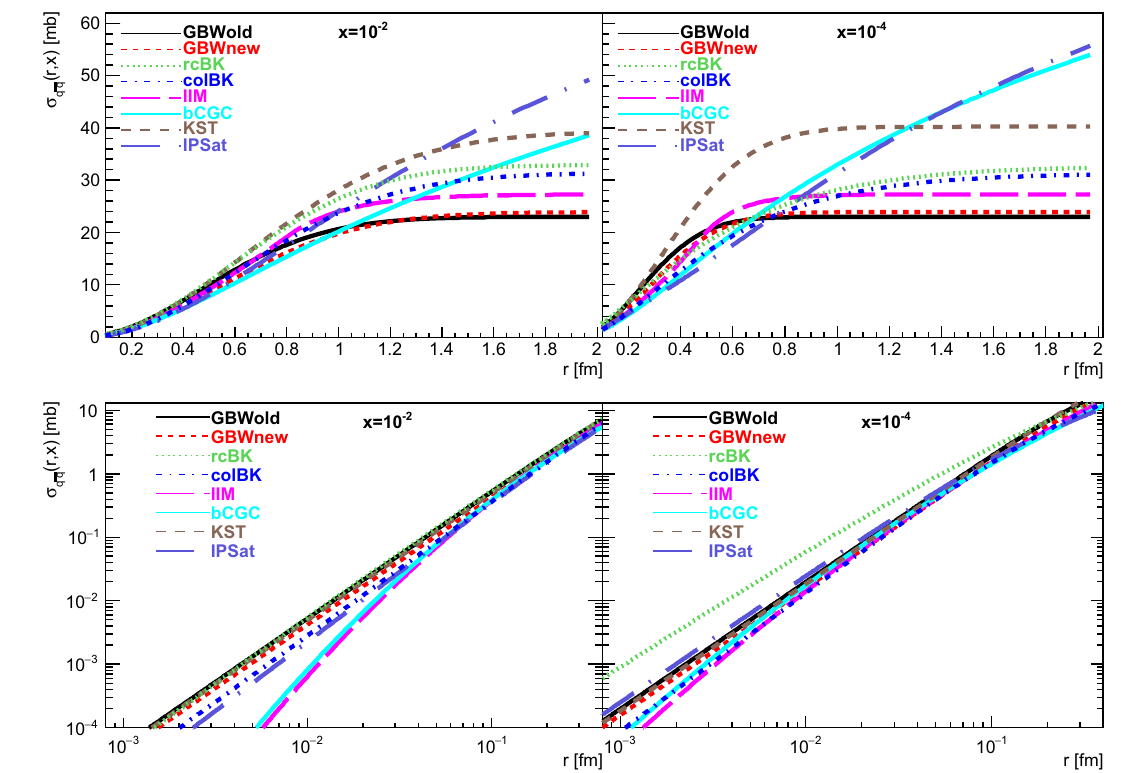
Fig. 5 Comparison of different parametrisations for the dipole cross section used in our calculations as described in the text